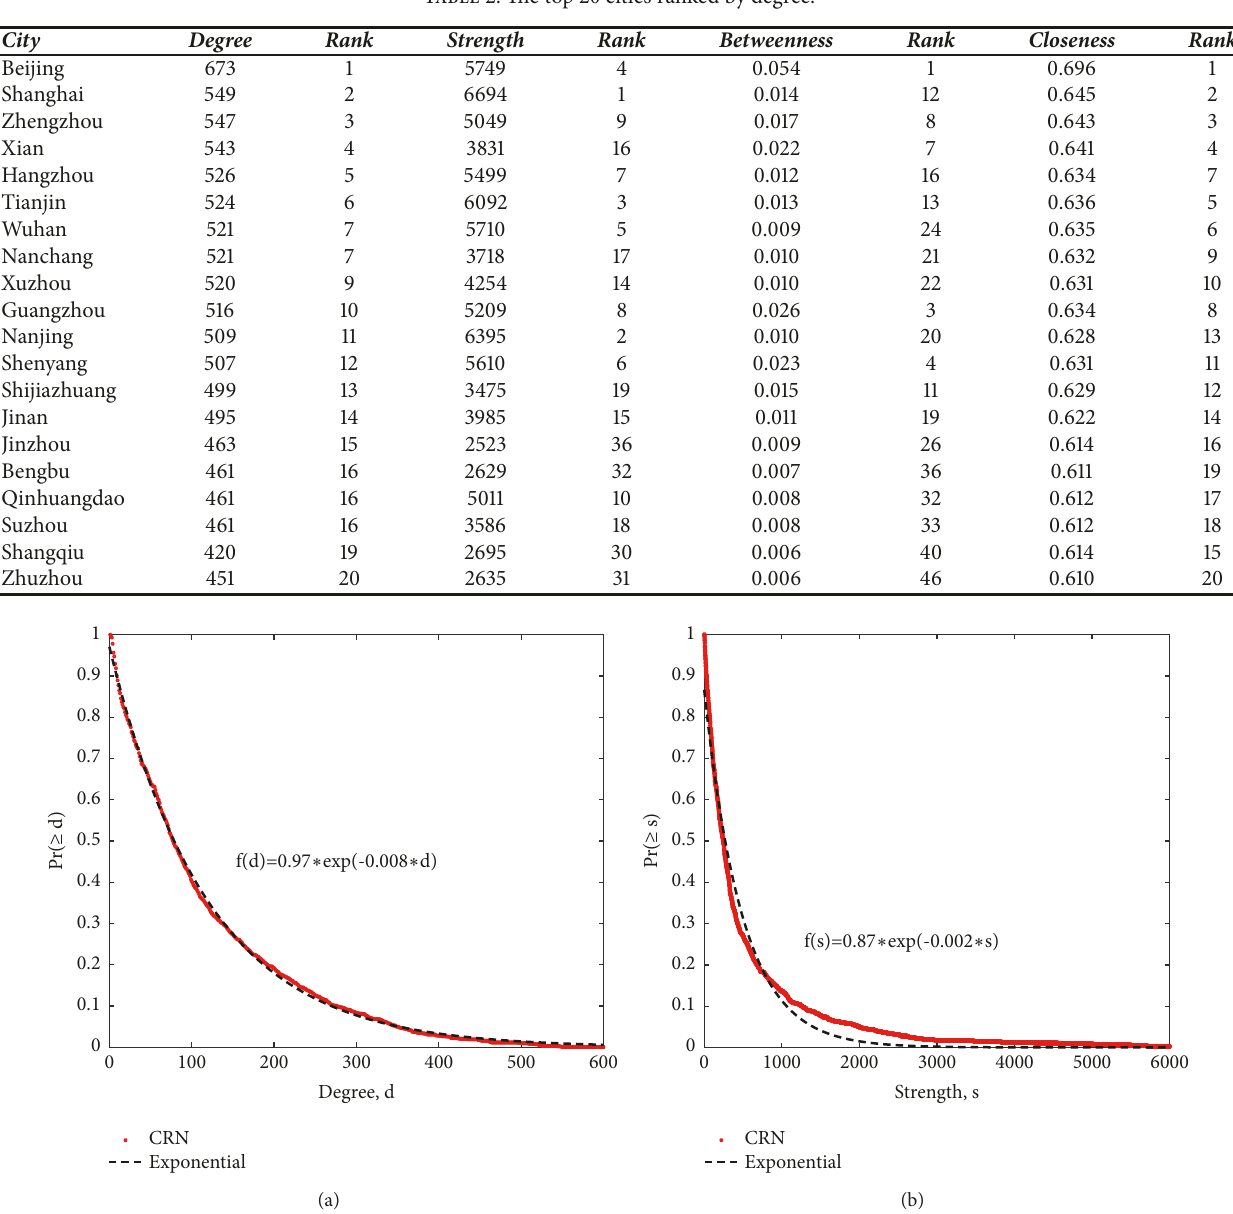
Figure 4: (a) The cumulative distribution of the nodal degree in CRN. (b) The cumulative distribution of the nodal strength in